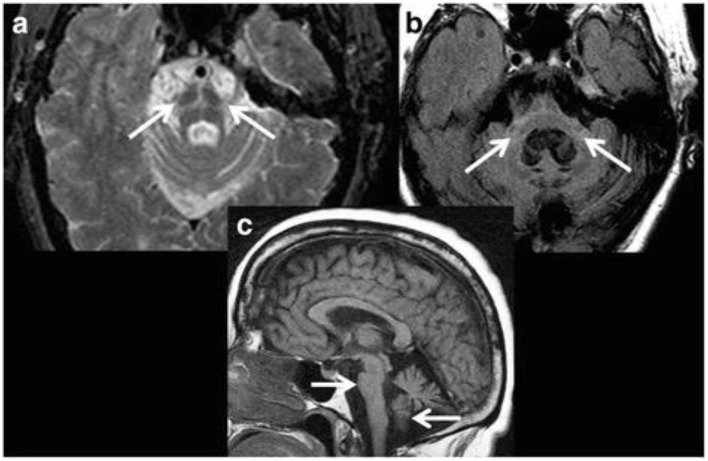
Magnetic resonance imaging of a patient clinically-diagnosed with multiple system atrophy (cerebellar type). (a) Axial proton density weighted sequence is presented at the level of pons, which shows cruciform pontine T2 hyperintensity as consistent with the “hot cross bun” sign, resulting from selective susceptibility of the pontocerebellar tract in multiple system atrophy (cerebellar type). In addition, disproportionate atrophy of the pons and partially visible cerebellar hemispheres are also apparent. (b) Axial fluid-attenuated inversion recovery (FLAIR) sequence is presented with cruciform T2 hyperintensity within the pons and middle cerebellar peduncles (i.e., “middle cerebellar peduncle” sign) along with marked atrophy. In addition, cerebellar hemispheric and vermian atrophy is evident with ex vacuo dilatation of the fourth ventricle. (c) Sagittal T1-weighted sequence is presented showing disproportionate atrophy of the brainstem and cerebellar vermis. Figure reproduced from Saeed et al. (10), under the Creative Commons Attribution License 4.0 (https://creativecommons.org/licenses/by/4.0/).